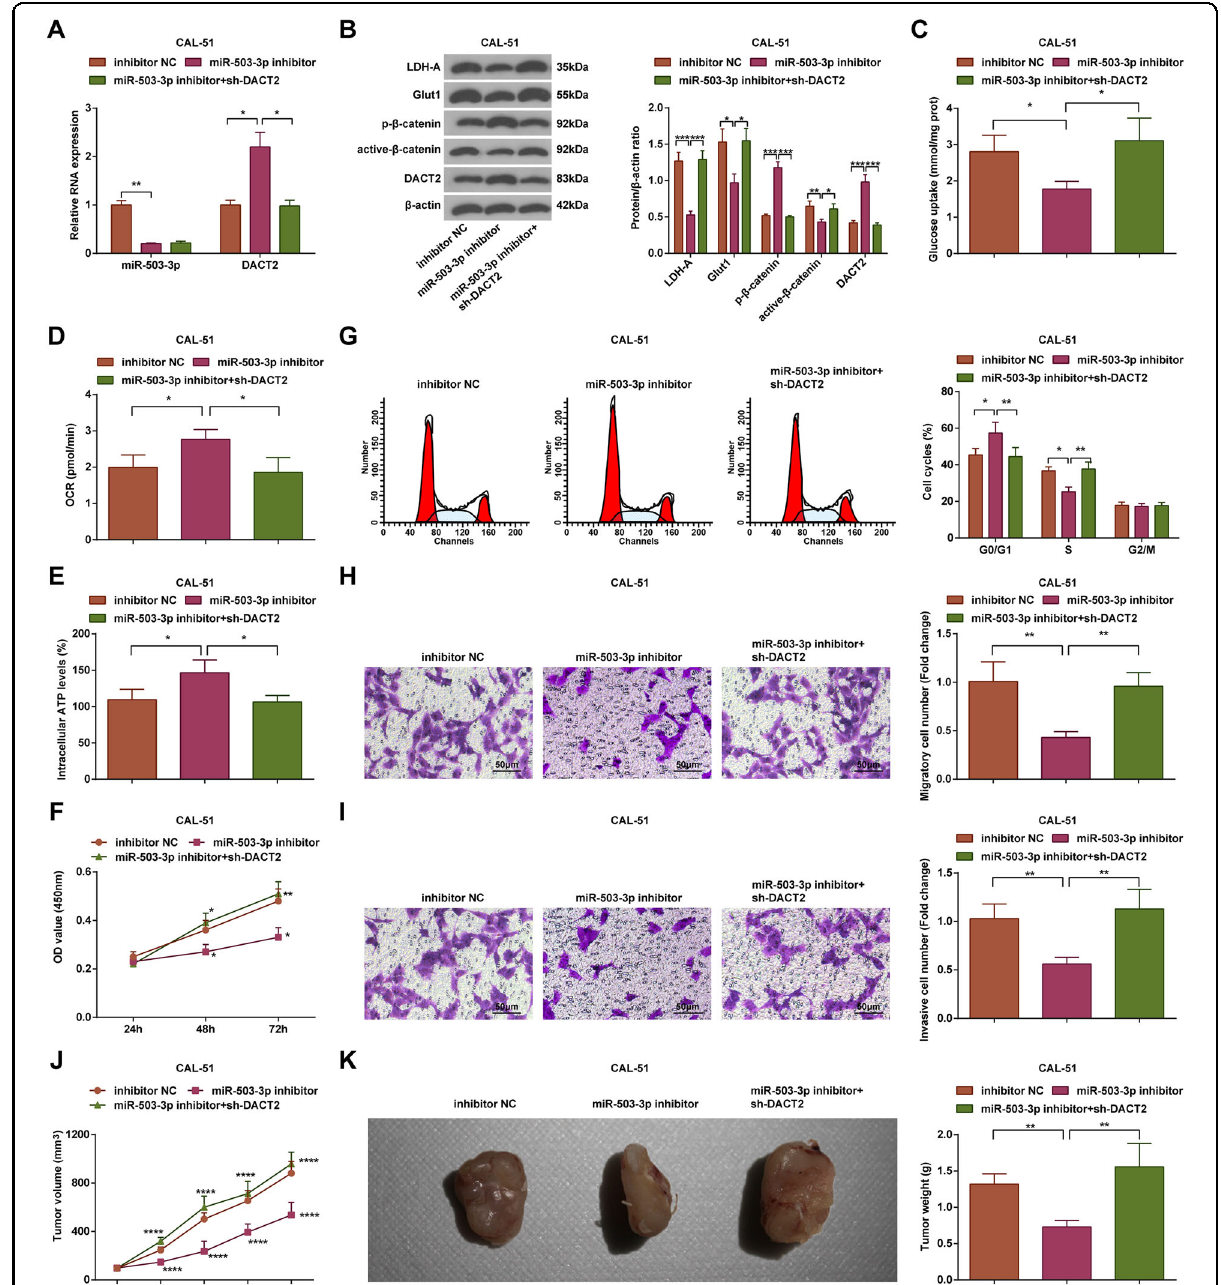
Fig. 3 MiR-503-3p/DACT2 axis regulates the Wnt/ β -catenin signaling pathway, glycolysis, and mitochondrial OXPHOS in BC cells. A RT- qPCR measured miR-503-3p and DACT2 expression in CAL-51 cells; B western blot measured DACT2, active- β -catenin, p- β -catenin, Glut1, and LDH-A protein expression in CAL-51 cells; C glucose intake of CAL-51 cells, D oxygen consumption rate of CAL-51 cells; E ATP level in CAL-51 cells; F CAL-51 cell viability; G fl ow cytometry determined cell cycle distribution. H , I Transwell assay tested migration and invasion ability of CAL-51 cells; J , K tumor volume and weight of nude mice that had been injected with CAL-51 cells; repetitions = 3 in ( A – I ), n = 6 in ( J , K ); * P < 0.05; ** P < 0.01; *** P < 0.001; **** P < 0.0001; the measurement data were expressed as mean ± standard deviation and compared using Student ’ s t test.